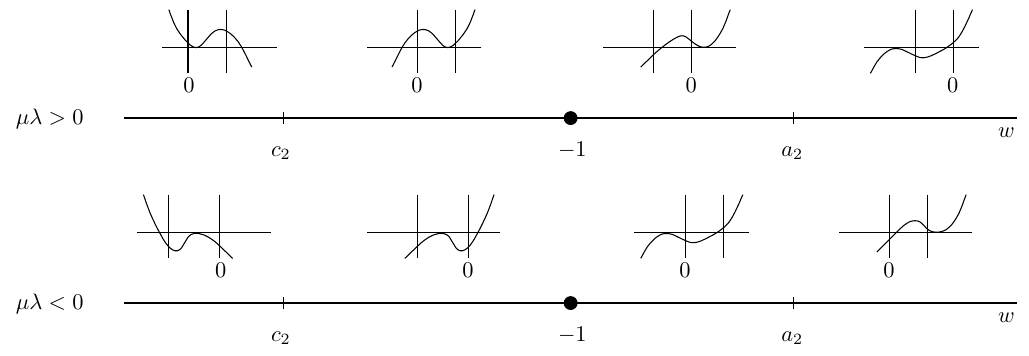
Figure 22. Pro(cid:12)le of the function U (+ ; (cid:0) ) 1 . The vertical line in each potential plot with label 0 denotes the point (cid:27) = 0 and the unlabelled vertical line is the point (cid:27) = (cid:0) (cid:22)